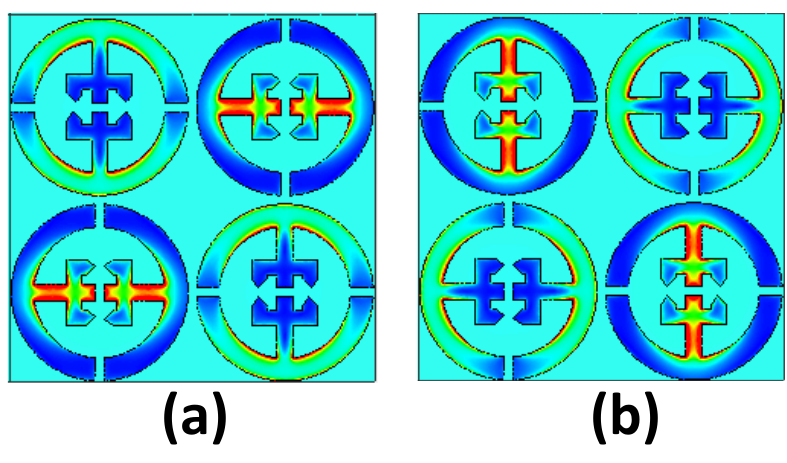
Figure 7. Numerical results showing the magnitude of the surface current across the surface of the 2 × 2 supercell for ( a ) polarization 1, and ( b ) polarization